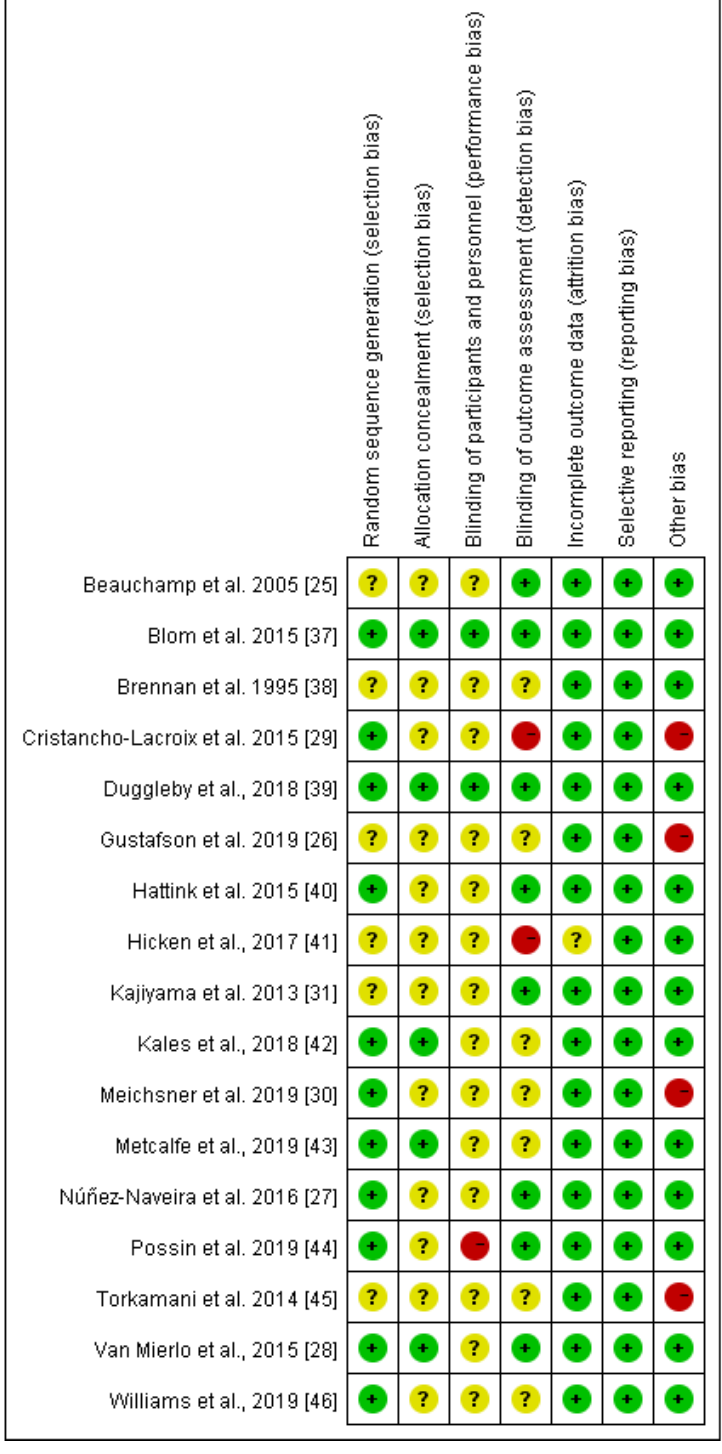
Figure 2. Risk of bias summary: review of the authors' judgments about each risk of bias item for each included